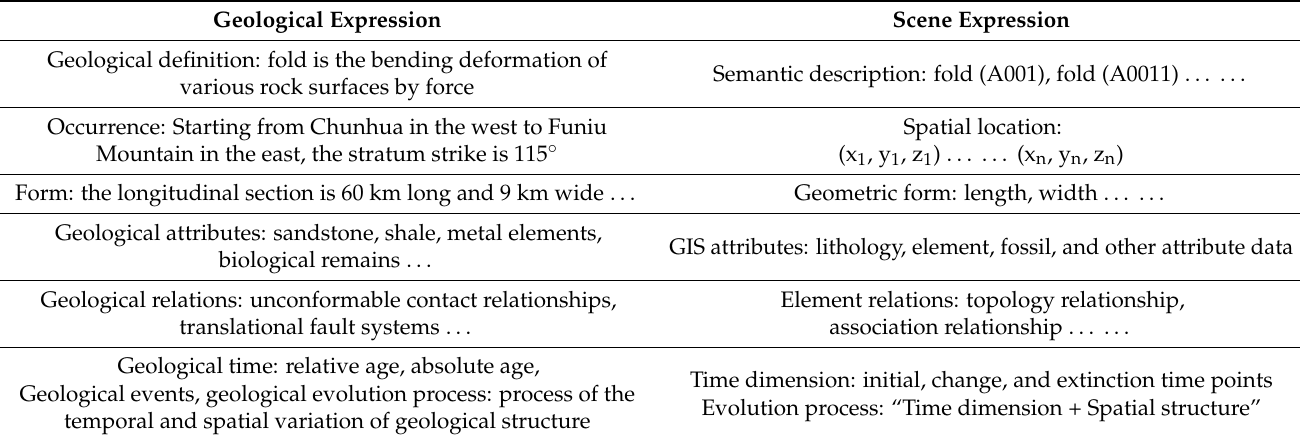
Figure 1. Correspondence between geological expression and GIS expression. The corresponding relationship between the geological expression of regional geologi- cal structures and scene expression in this paper is as follows: Geological definition and GIS semantics; occurrence and GIS spatial location; form and GIS geometric form; geologi- cal attributes and GIS attributes; contact relations, combination forms, and GIS elements; geological time, geological events, and GIS time dimension; and evolution processes. The corresponding relationships between geology and GIS expression are shown in Table 1. Table 1. Corresponding relationship between geology and the GIS expression of regional geological